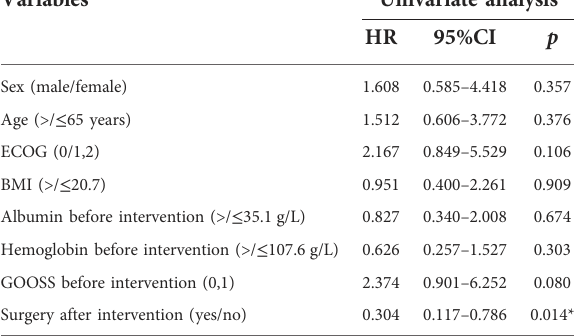
TABLE 4 Prognostic factors for overall